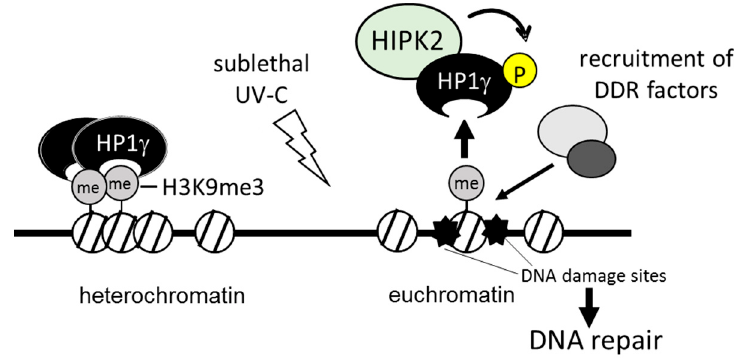
Figure 4. Schematic summary of HIPK2-mediated chromatin modification. Heterochromatin protein 1 γ (HP1 γ ) binds to the methylated histone H3 and forms heterochromatin. In response to sublethal stress, HIPK2 phosphorylates HP1 γ and facilitates its release from histone and promotes recruitment of DDR factors to the damaged sites for DNA repair. UV-C, ultraviolet-C.